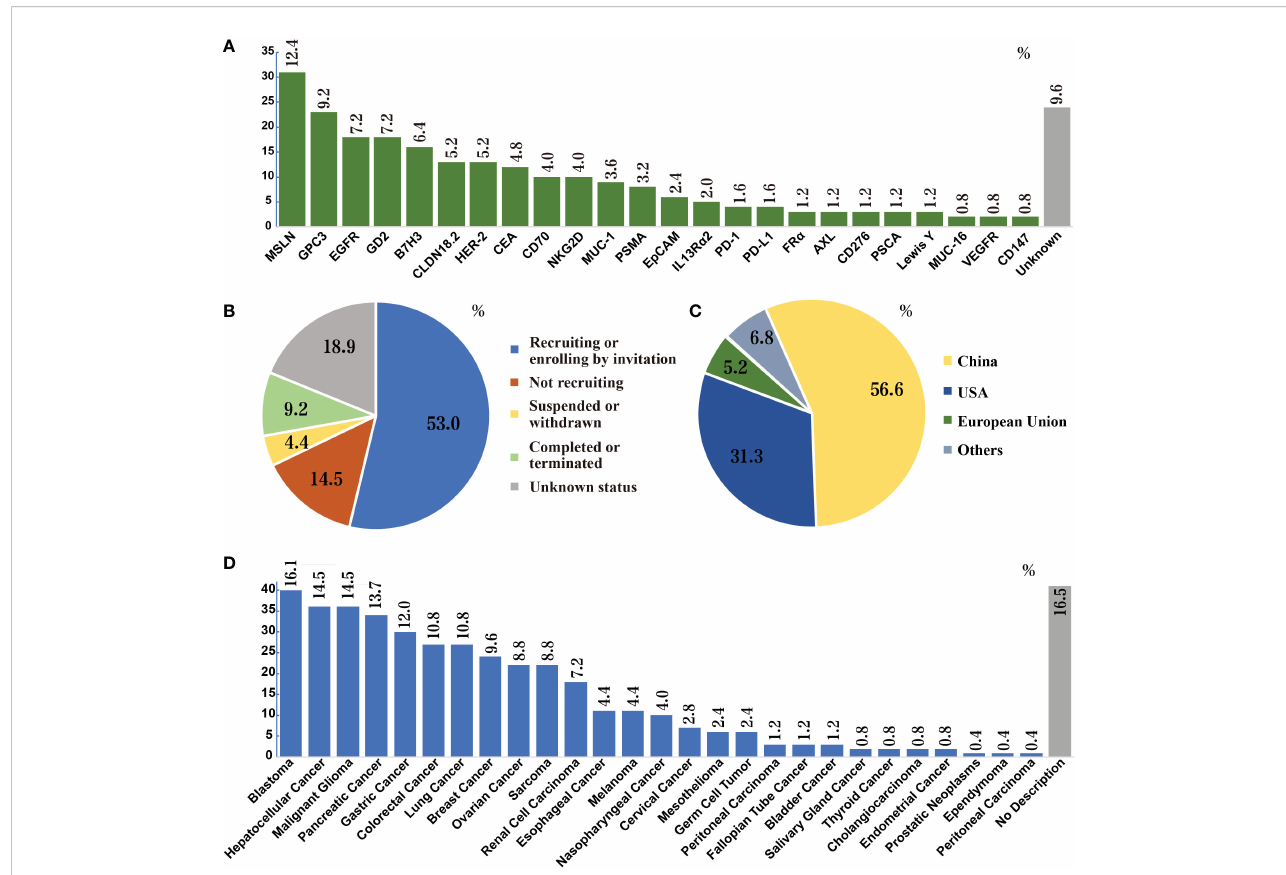
FIGURE 2 Search results of CAR-T cell therapies for solid tumors in NIH Clinical Trials Database (as of November 21, 2022). (A) Research frequencies of every target. (B) Status of clinical trials; over 60% of trials are ongoing. A total of 53 targets appeared in these clinical trials. The fi gure does not list the targets that appear only once (0.4%), which are: CD20, EphA2, CLDN6, CD40, TM4SF1, EpCAM, Nectin4/FAP, AFP, B4T2-001, ROR2, U87, ALPP, CD52, CD22, IL17R a , CAIX, IM83, E2, IM92, CD171, IM96, ROR1, KKLC1, TAG72, CD56, CD33, MMP2, ICAM1 and gp100. (C) Countries or regions where the trials are located. The most clinical trials of CAR-T cell therapies for solid tumors are conducted in China, followed by the U.S. (D) Species of solid tumors studied in the clinical trials. Liver cancer, pancreatic cancer, breast cancer, sarcoma, and lung cancer are the fi ve most studied solid tumors in clinical